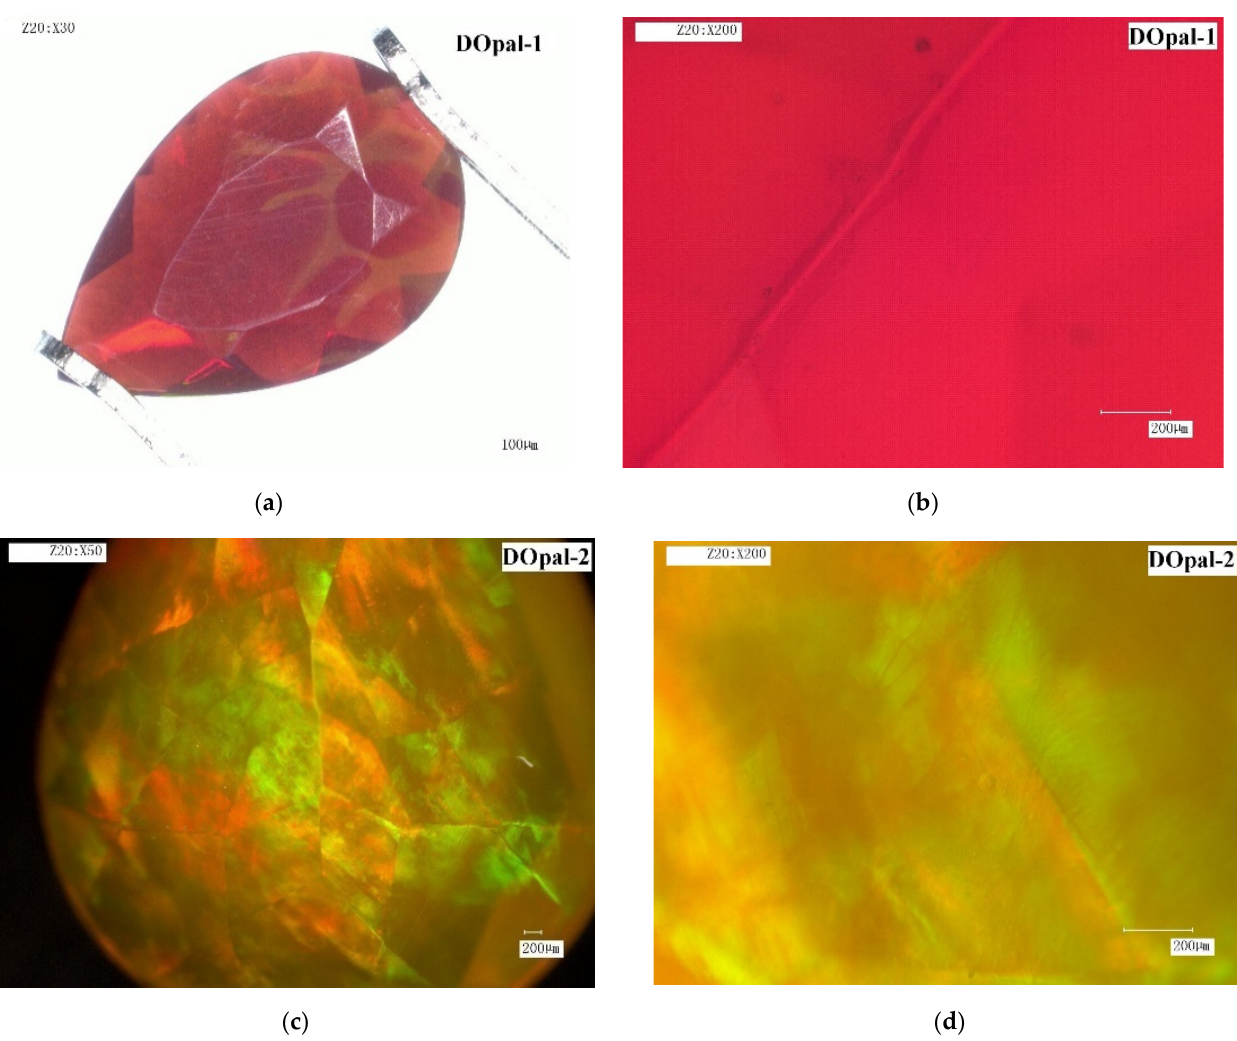
Figure 3. Digital micrographs of sample NOpal-2 and NOpal-3. ( a,b,c ) Even color distribution; ( d ) Color bands.